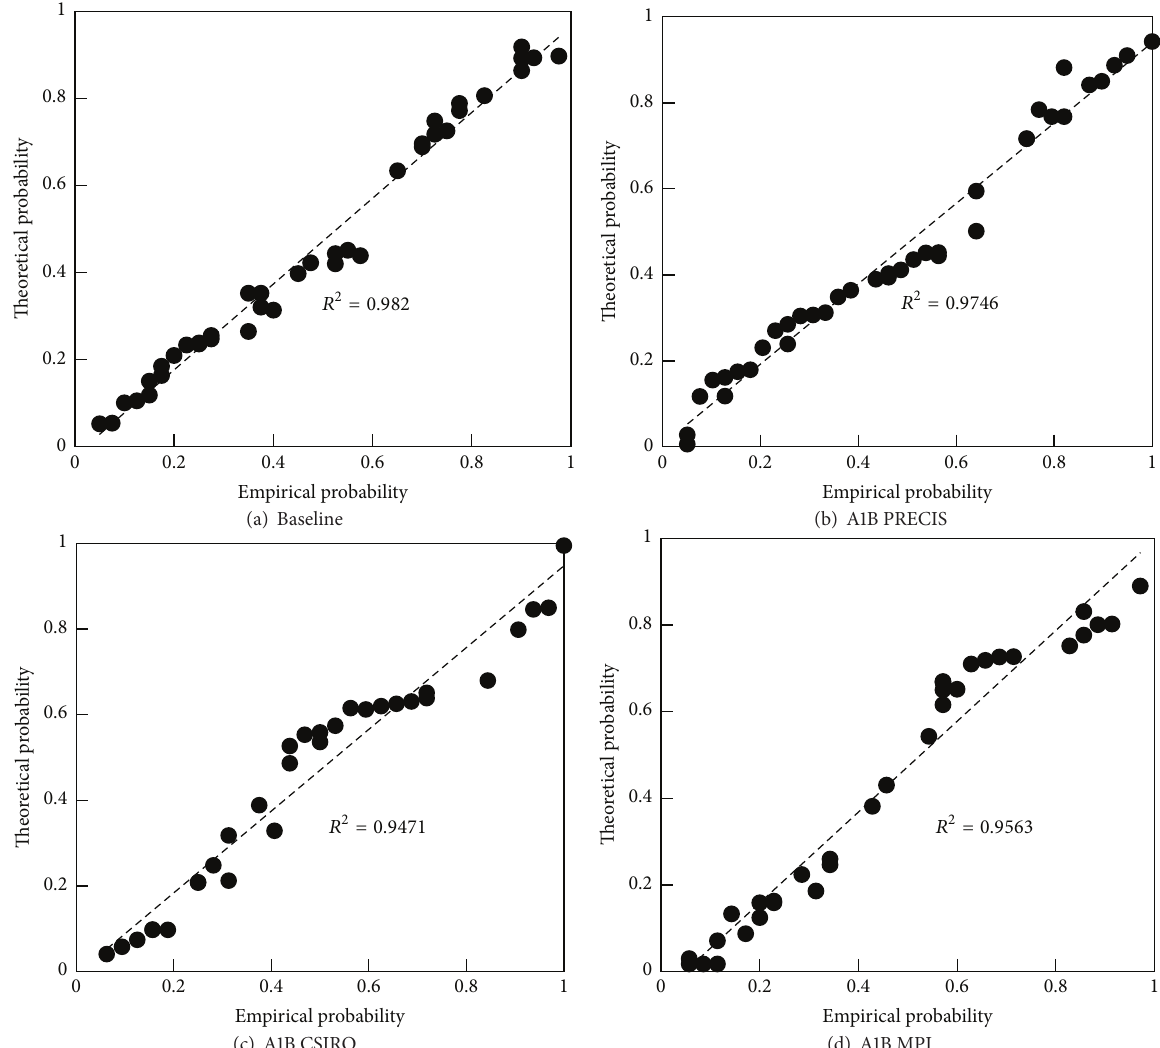
Figure 5: Empirical and theoretical joint probabilities of drought severity and duration under baseline and three A1B